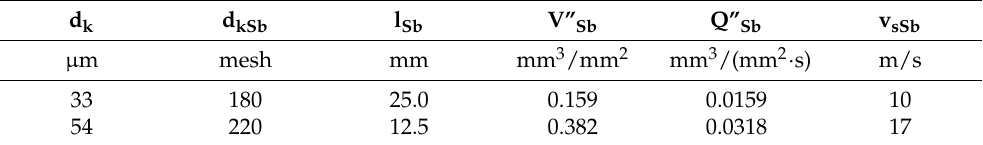
Table 1. Investigated sharpening